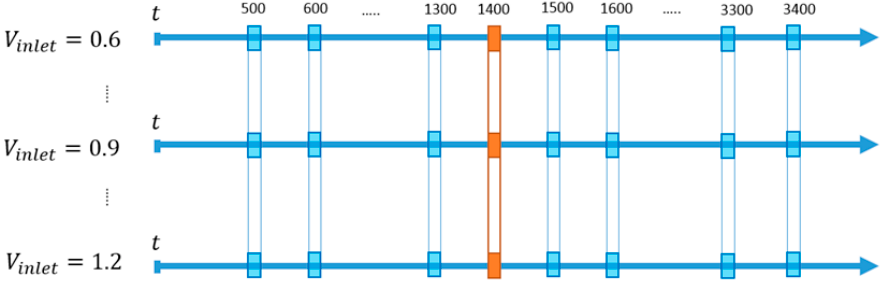
Figure 44. Time steps selected for time average.